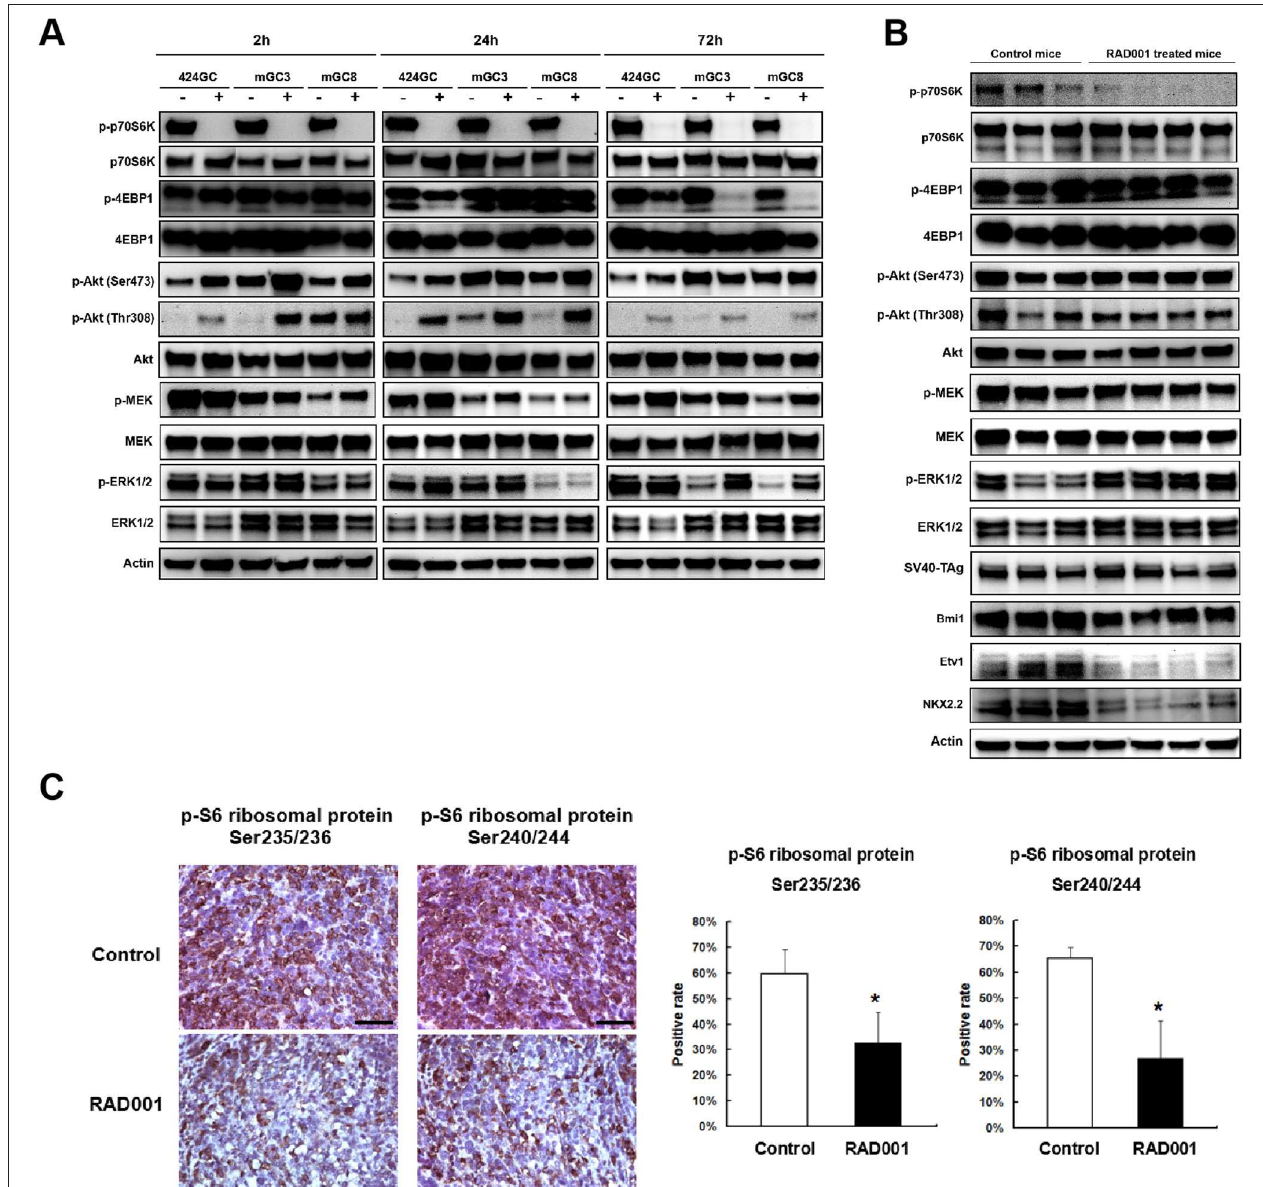
FIGURE 4 | RAD001 efficiently inhibited the mTOR-p70S6K signaling while inducing a feedback activation of PI(3)K–Akt–mTOR and MEK/ERK pathways. (A) The expression of phosphorylated and total p70S6K, 4EBP1, Akt, MEK, and ERK1/2 was evaluated in the primary tumor cell lines and cells treated with RAD001 for 2, 24, and 72h with western blot. The same analysis was applied to the tumor tissues from RAD001 treated mice and control mice after 48 days of treatment with RAD001 or placebo (B) . (C) Staining for p-S6 ribosomal protein was applied to tumor sections from RAD001 treated mice and control mice. Scale bars: 50 µ m. Statistical analysis for p-S6 ribosomal protein positive cell rate is shown on the right. * p < 0.05: RAD001 treated group vs. control